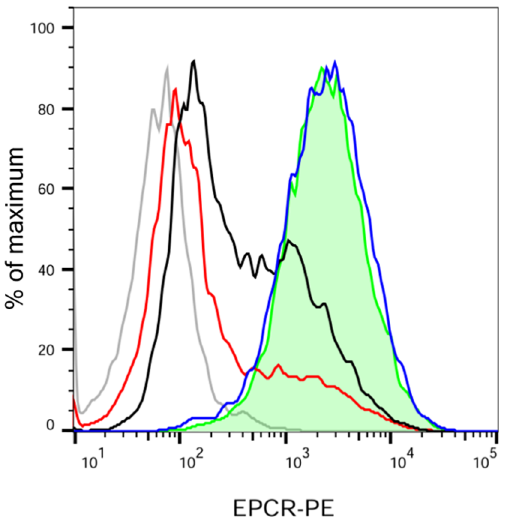
Fig 3. Meningococcal type IV pili trigger the decrease of EPCR expression. HDMEC were infected with either a WT N . meningitidis strain at a Multiplicity Of Infection (MOI) = 25 (red), Opa+ Δ SiaD strain at MOI = 25 (black), Opa + Δ SiaD Δ pilE strain at MOI = 500 (blue–see Material and Methods) or left uninfected (green, tinted) for 4 hours (grey: isotype control). EPCR expression was assessed by a FACS analysis. Data are representative of 3 independent experiments. (grey: isotype control). For the quantification of EPCR expression see supplemental data S1 Fig .